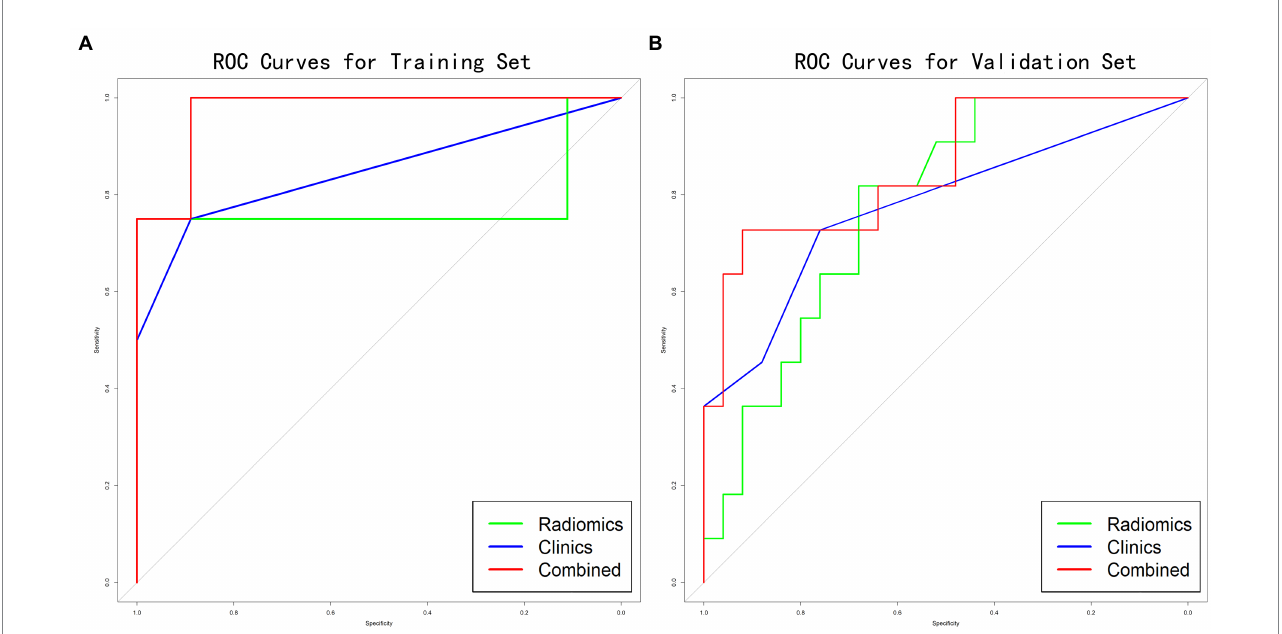
FIGURE 3 Comparing the prediction abilities of malnutrition in the training (A) and validation (B) sets. The performance of the combined prediction model (respective AUC values of 0.972 and 0.855 in the training and validation set) was greater than the radiomics or clinical model.